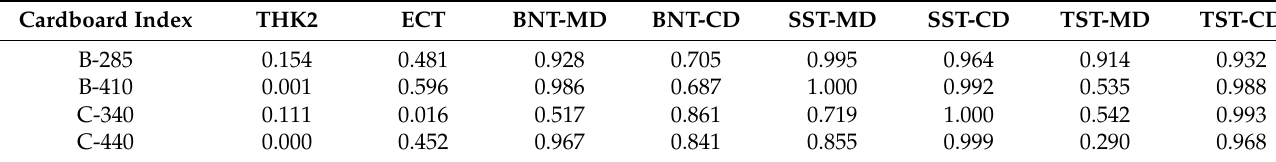
Figure 13. The decreases in measured values for C ‐ 440 corrugated cardboard in: ( a ) BNT; ( b ) SST; ( c ) TST; ( d ) ECT and ( e ) THK2. Table 3. The coefficient of determination R 2 between crushing and normalized values.